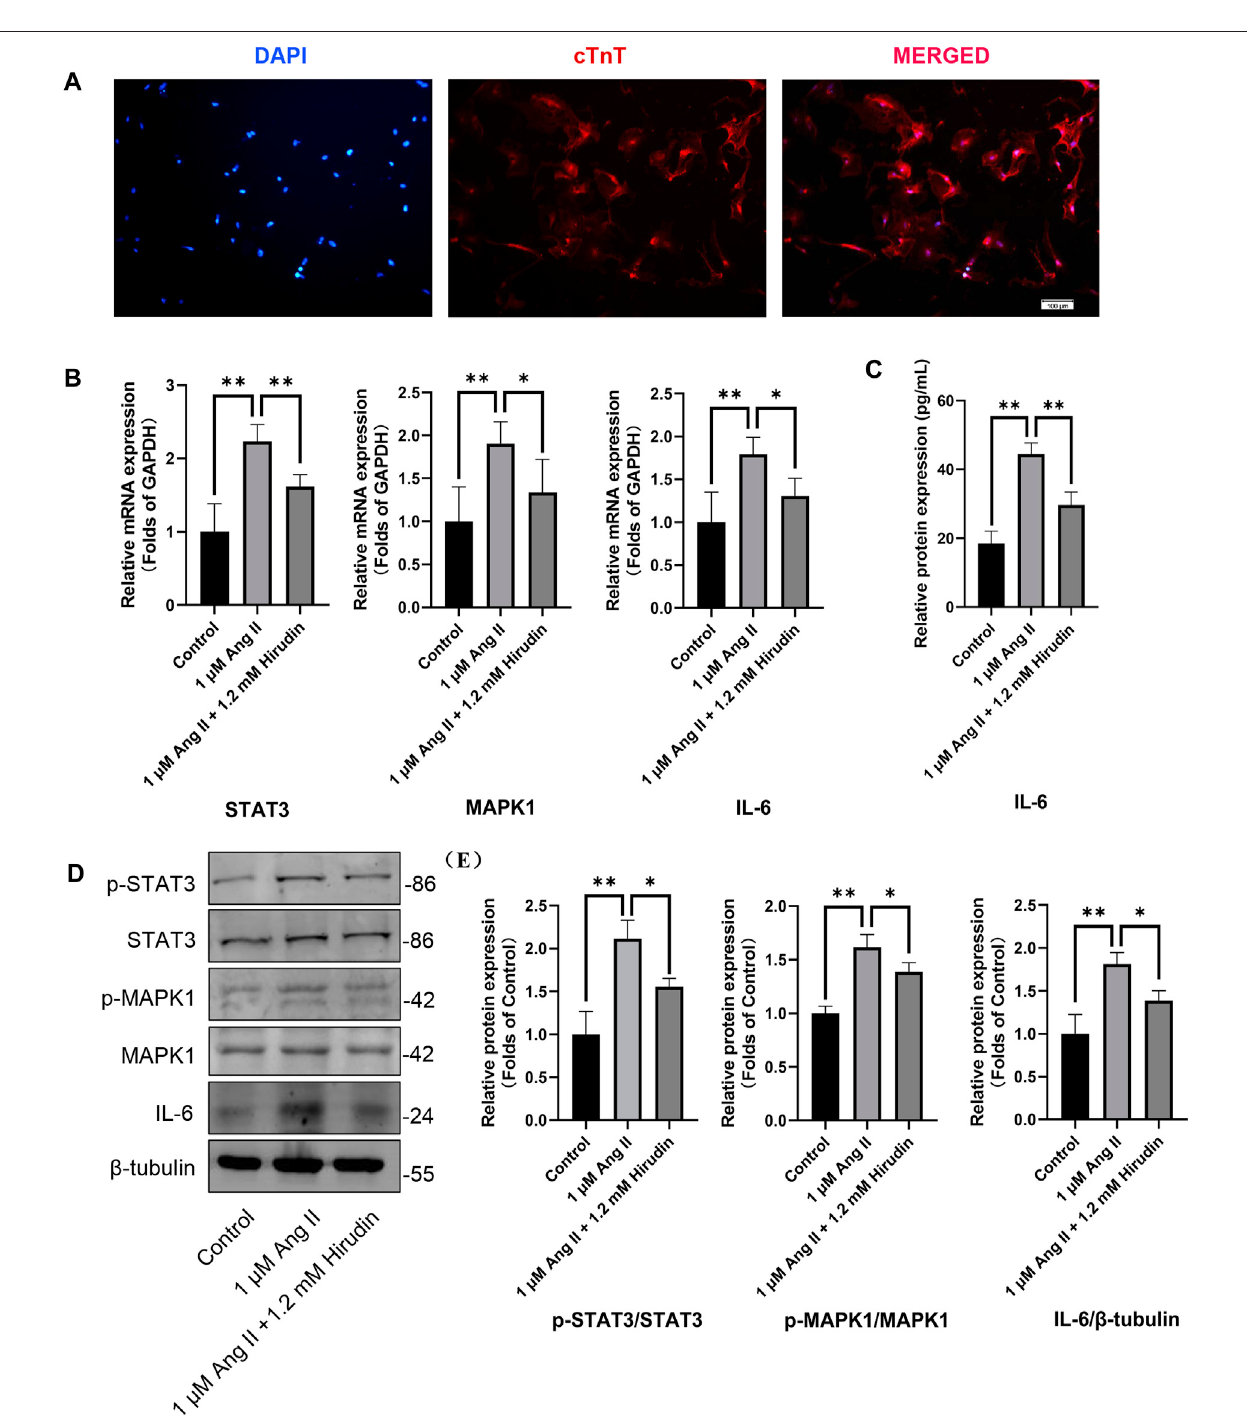
FIGURE9| Neonatalratcardiomyocytesweretreatedwith1 μ MAngIIand1.2 mMhirudinfor24 h. (A) Immuno fl uorescencestaining(cTnT)identi fi edtheobtained cells were cardiomyocytes, and the red staining area was troponin speci fi cally expressed by cardiomyocytes. (B) The expression of STAT3, MAPK1 and IL-6 were analyzed by qRT-PCR, n = 6. (C) The IL-6 in cell supernatant was assayed by ELISA, n = 5. (D) Western blot for the expression of proteins including STAT3, p-STAT3, MAPK1, p-MAPK1 and IL-6. (E) Quanti fi ed by western blot analysis and normalized to control, n = 3. Bars represent the mean ± SD, * p < 0.05, ** p < 0.01.